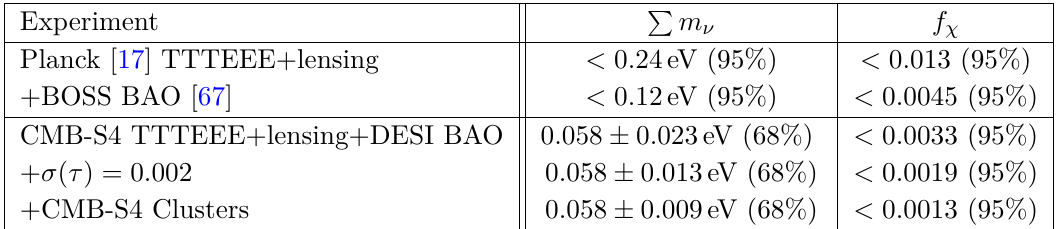
Table 1 . Current constraints and future projections [66] for P m ν and the derived constraint on f χ assuming P m ν = 58 meV is the fiducial value. We assume the dark matter couples equally to all three